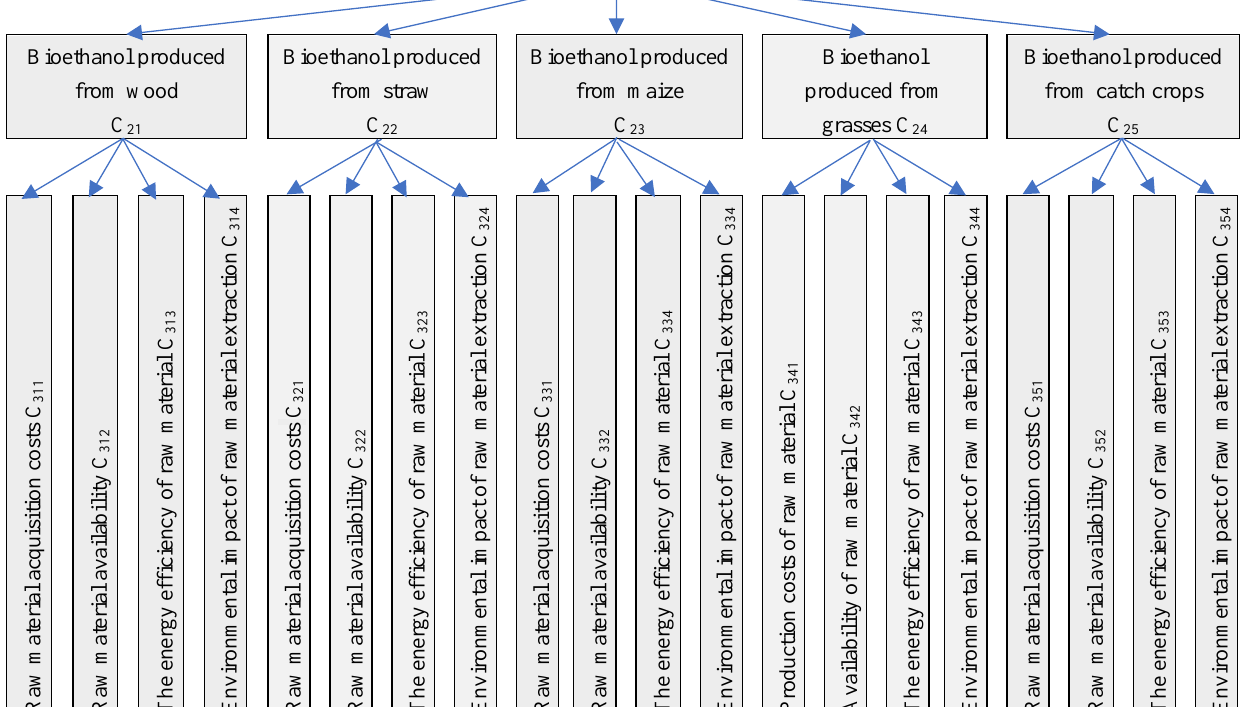
Table 2. Assessment of the importance of level II factors conditioning the development of second- generation bioethanol production in Poland.